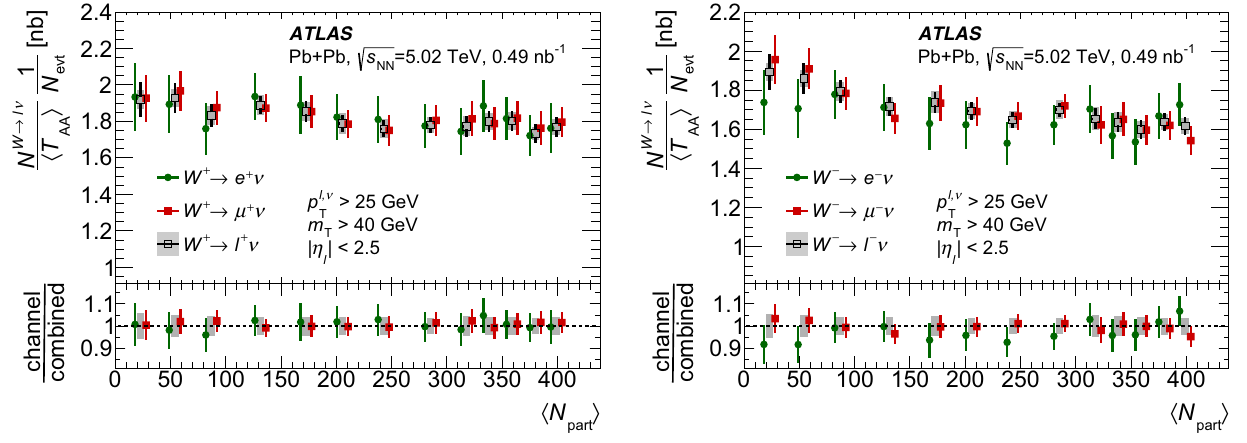
include the isospin effect. The normalised production yields for W ± bosonsdonotchangewith (cid:4) N part (cid:5) formid-centraland central collisions represented by (cid:4) N part (cid:5) values above 200. In